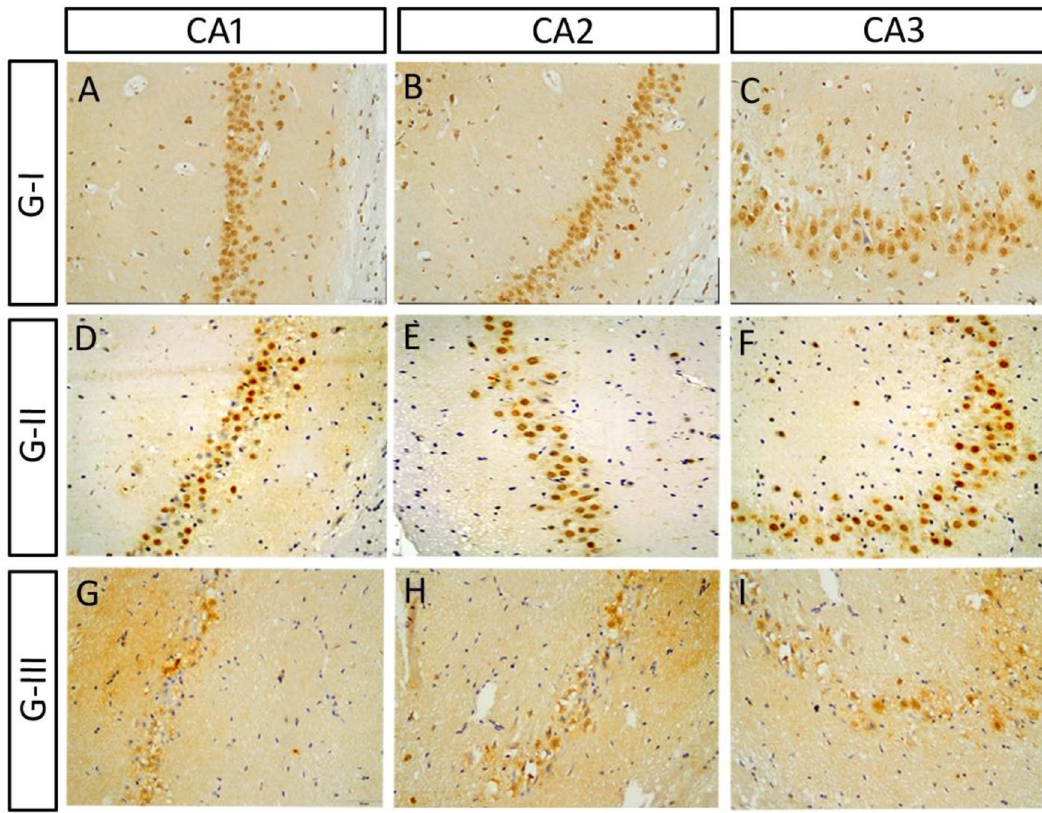
Figure 8. Expression of HCN in scopolamine administrated groups in CA: ( A – C ) The HCN1 immunoreactivity in the pyramidal layer of CA of the control group. ( D – F ) The HCN1 immunoreactivity in group II was comparable to that of the control group in CA. ( G – I ) The HCN1 immunoreactivity decreased significantly in ES group III in